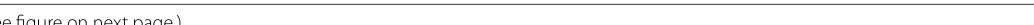
figure on next Fig. 4 The small-molecule compound did not abolish the activity of InvC ATPase. A Purification of soluble GST-InvC fusion protein from bacterial cell lysates. B The optimal concentration of InvC ATPase recombinant protein for ATP hydrolytic activity was 10 μg/μL. C The compound did not interfere the ATP hydrolysis reaction with InvC ATPase. The data presented from three independent experiments and values were expressed in standard deviations from means. The reaction without inhibitor was used as the